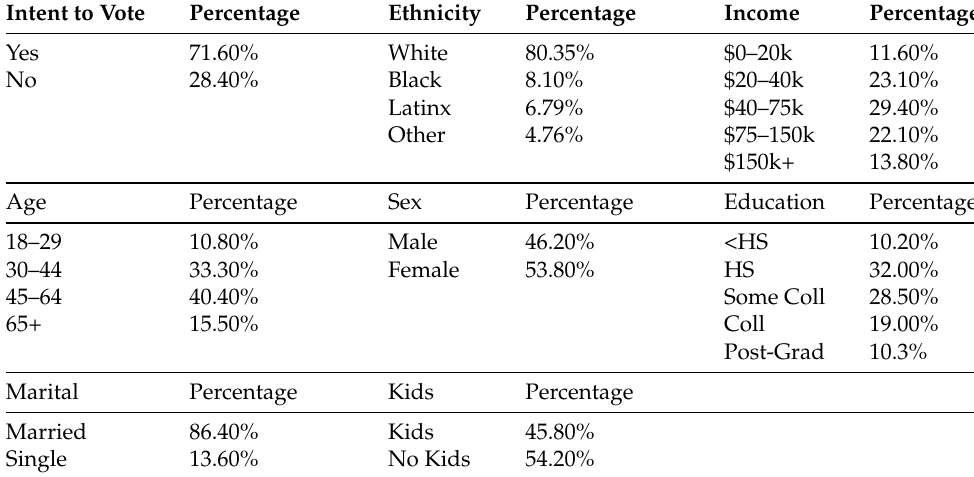
Table 1. CPS Post-Election Voting and Registration